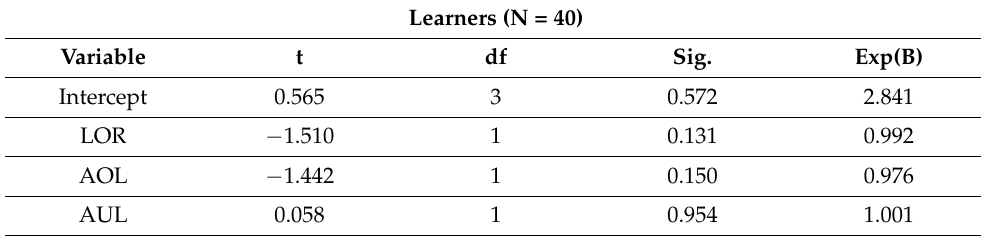
Table 2. Predictors of intonational accuracy for 20 L2 Italian and 20 L2 Spanish learners.